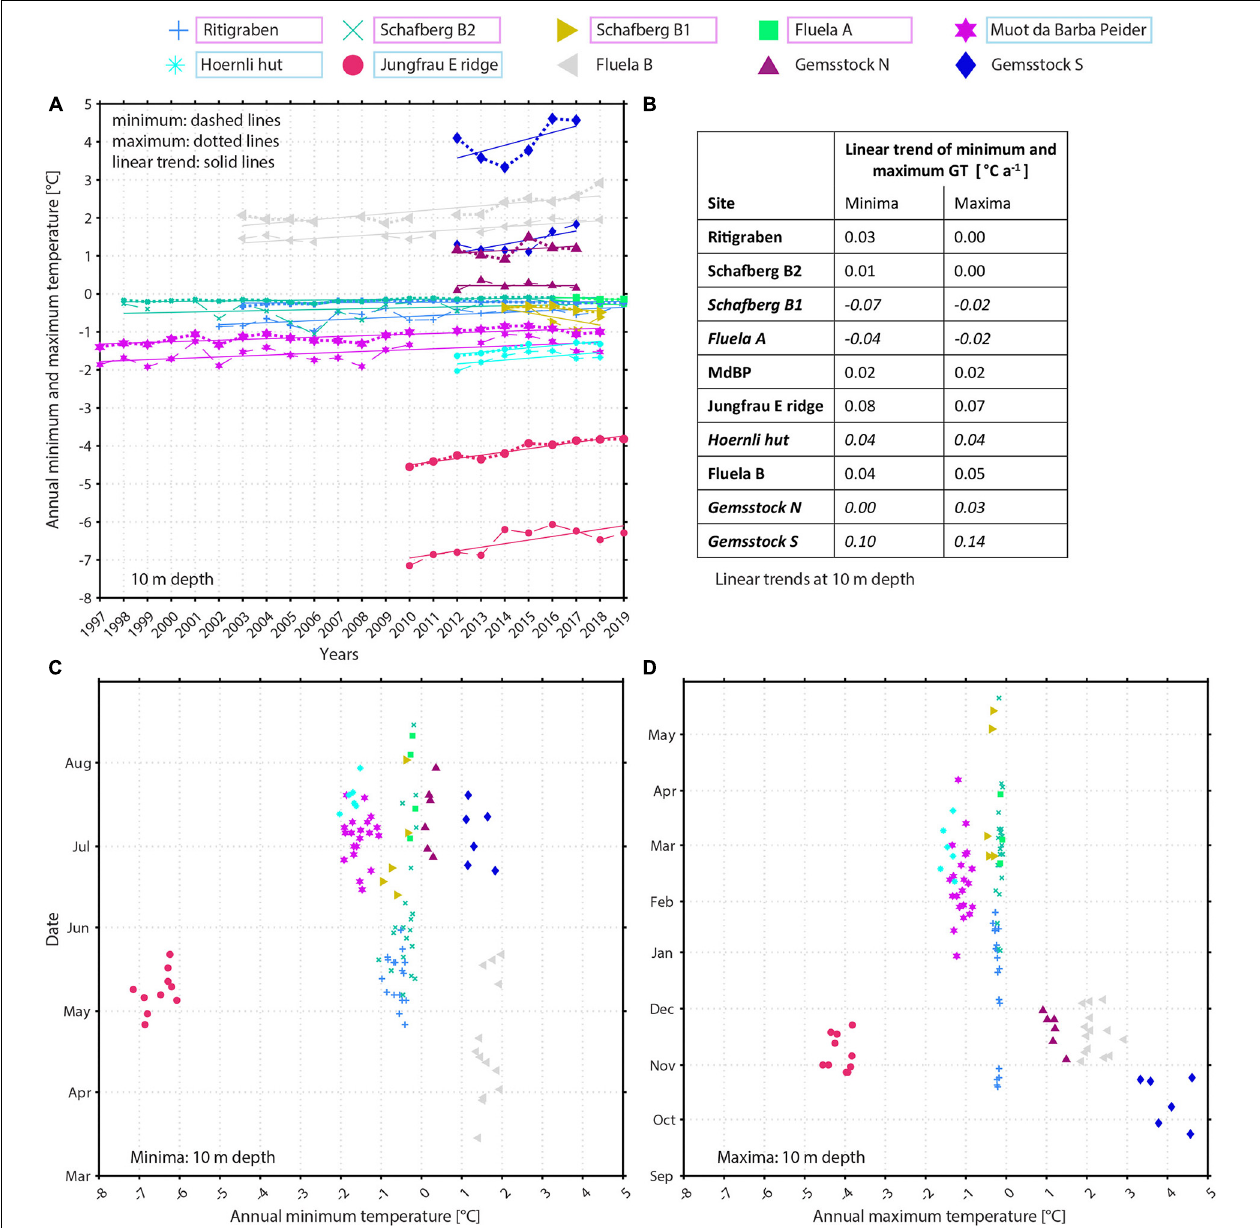
FIGURE 10 | (A) Evolution of annual minimum (dashed lines) and maximum (dotted lines) ground temperatures at 10 m depth. In addition, linear trends (solid lines) are calculated based on the evolution of annual minima and maxima. (B) Annual minimum and maximum ground temperature trends [ ◦ C a − 1 ] at 10 m depth. Muot da Barba Peider B1 is abbreviated as MdBP. Results for boreholes with only short data time series are written in italics. (C,D) Timing as a function of (C) annual minimum and (D) maximum ground temperatures at 10 m depth: the dates for each borehole and each year on the y -axis versus minimum or maximum ground temperatures on the x -axis are shown. Note the different y -axis scales for minima and maxima. The coloured frames indicate the ice content of the boreholes: pink for ice-rich, light blue for ice-poor, and no frame for permafrost-free